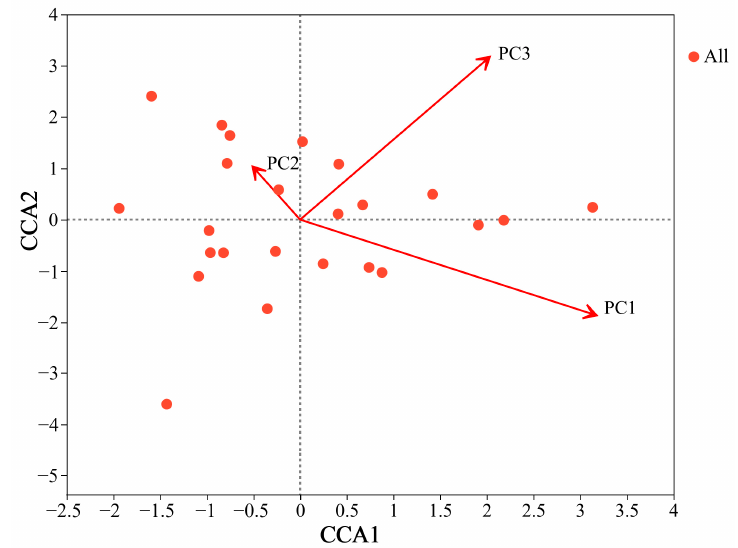
Figure 3. Canonical correspondence analysis (CCA) ordination plots of the relationship between all principal components (PCs) and arbuscular mycorrhizal fungi (AMF) community composition based on Bray–Curtis distance. Correlation between PCs and individual soil variables is presented in Table S5 The CCA1 and CCA2 axes accounted for the 34.3% and 31.4% of the total explained variation in AMF communities, respectively. The red dots are all samples collected in this study.